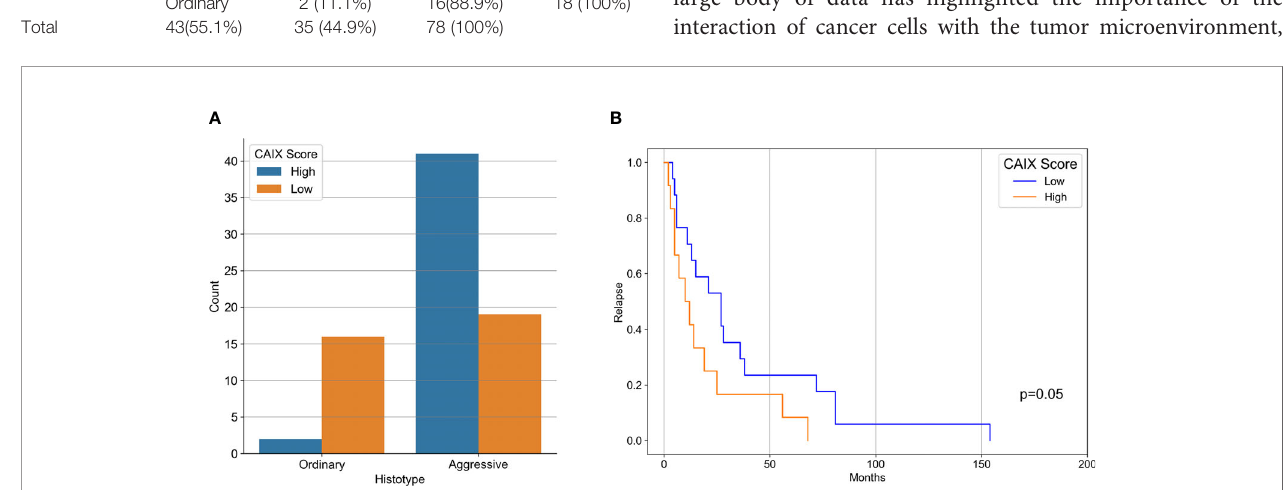
FIGURE 1 | (A) Bar-Graph representation of CAIX immunohistochemical expression in aggressive and ordinary BCC. (B) Kaplan-Meier curves of recurrence survival. Difference between CAIX HIGH and CAIX LOW curved proved statistically signi fi cant (p = 0.05) as tested by Log-Rank.